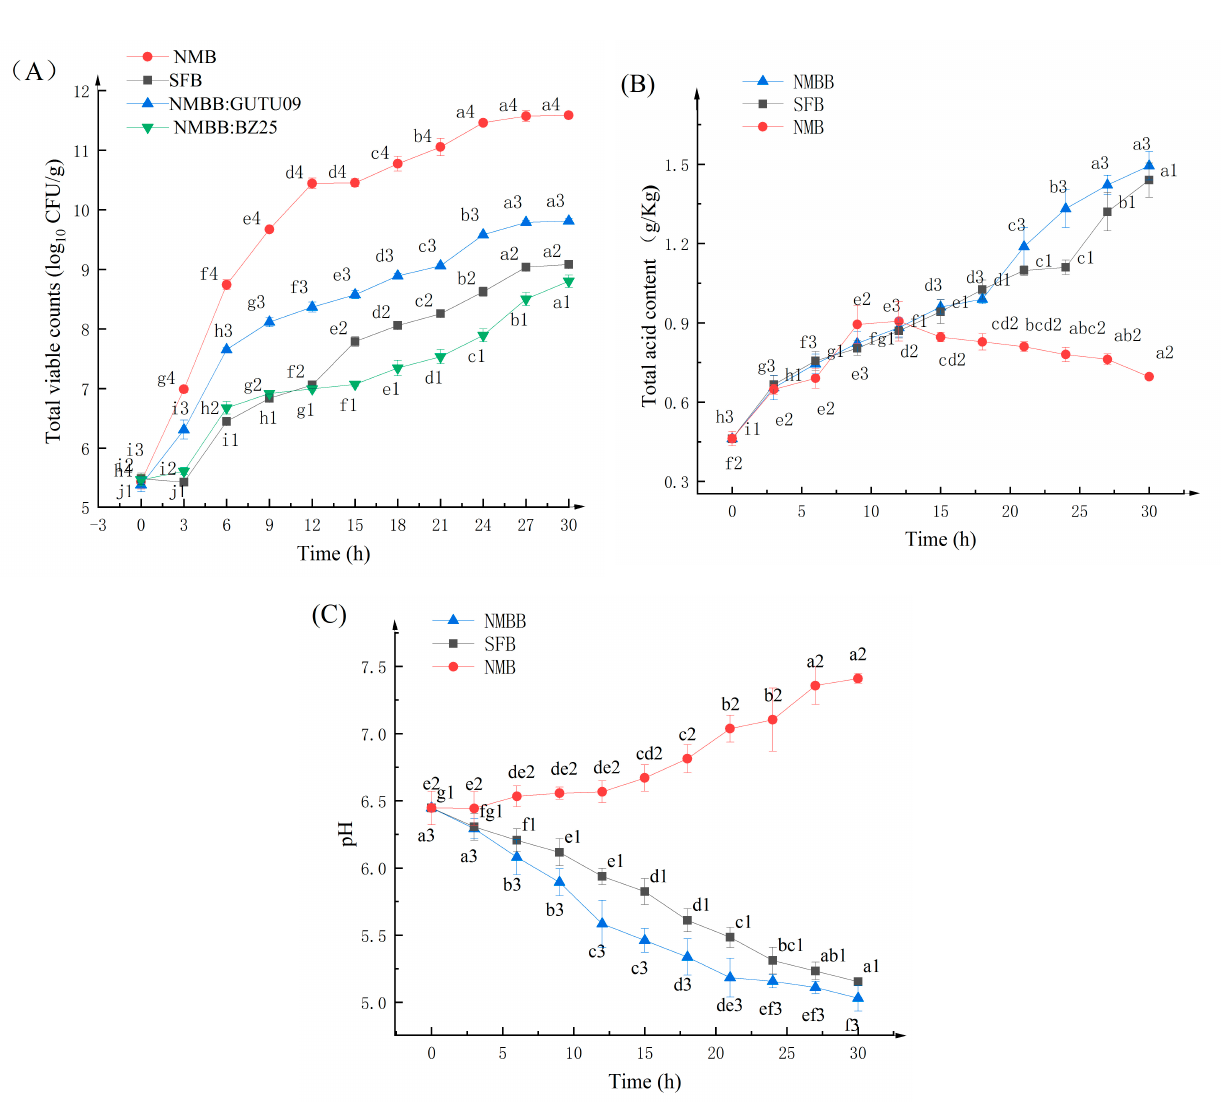
Figure 1. ( A ) Changes in the total viable count of SFB, NMB, and NMBB samples from 0 to 30 h. NMB: viable count of GUTU09 in NMB; SFB: viable count of BZ25 in SFB; NMBB: GUTU09: viable count of GUTU09 in NMBB; NMBB: BZ25: viable count of BZ25 in NMBB. Means with different characters (ai–hi, i = 1, 2, 3 or 4) on the same curve are significantly different ( p < 0.05), the same below. ( B ) Changes in titratable acid of SFB, NMB, and NMBB samples from 0 to 30 h. ( C ) Changes in the pH of SFB, NMB, and NMBB samples from 0 to 30 h.